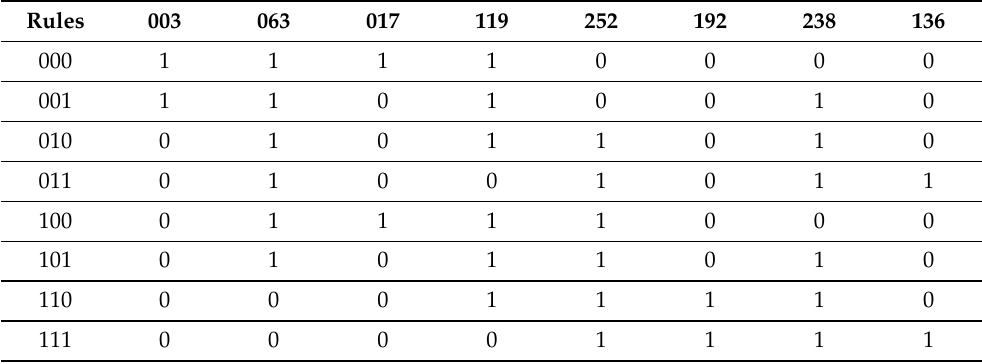
Table 1. Rules of elementary cellular automata interpreted as traffic models (Pt. 1).